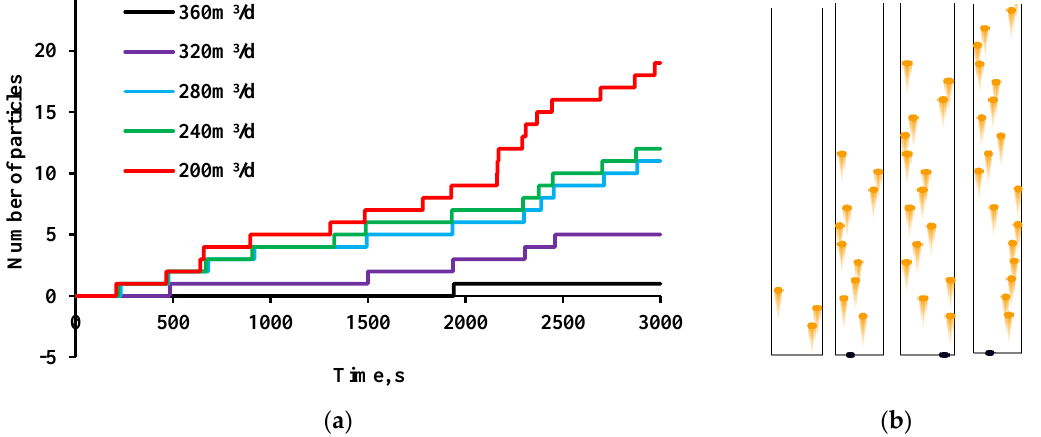
Figure 2. Number of CO 2 bubbles in wellbore under different daily injection−water quantities. ( a ) Particle number change; ( b ) Particle distribution state.